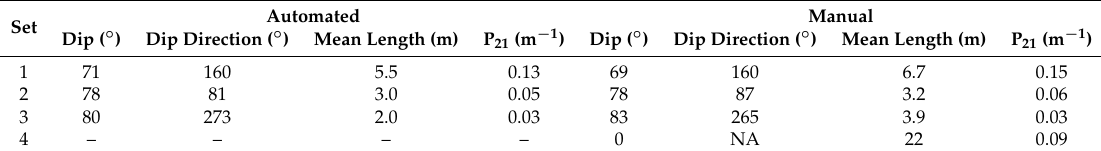
Table 2. Comparison of automated and manual virtual mapping results for Mine B.